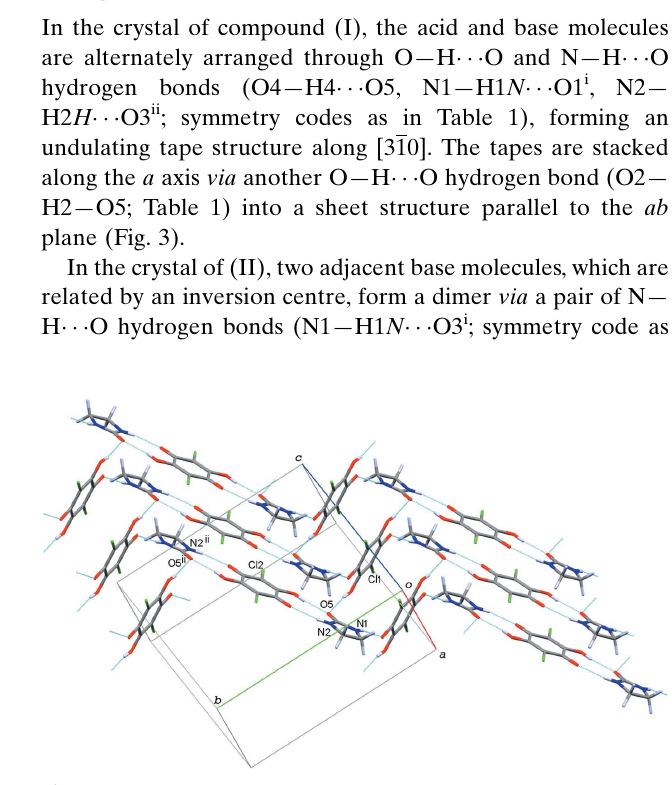
Figure 3 A partial packing diagram of compound (I), showing the undulating sheet structure formed by O—H (cid:2)(cid:2)(cid:2) O and N—H (cid:2)(cid:2)(cid:2) O hydrogen bonds (light- blue dotted lines). [Symmetry code: (ii) (cid:4) x , (cid:4) y + 1, (cid:4) z + 1.]